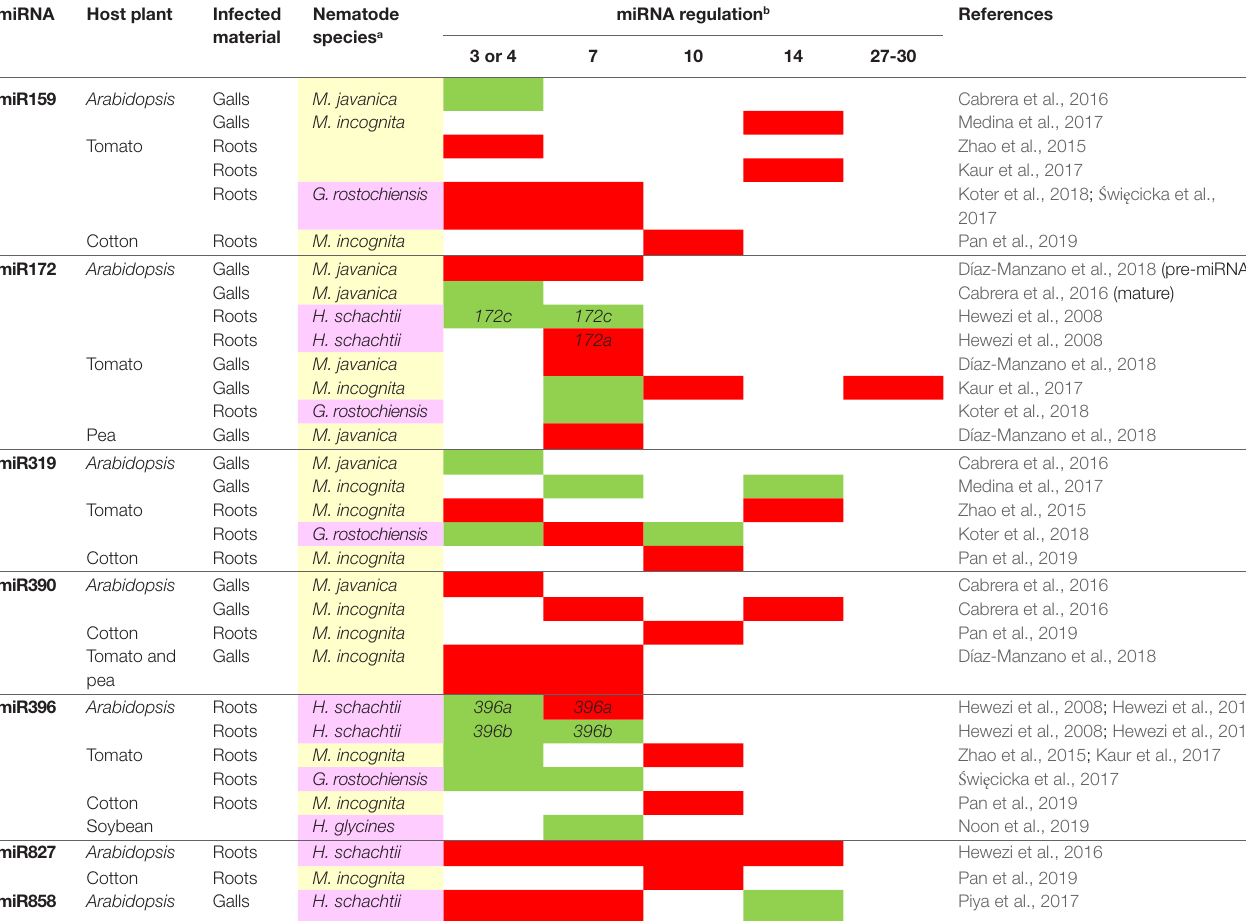
TABLE 1 | List of functionally validated miRNAs differentially expressed in response to RKN and/or CN. miRNA